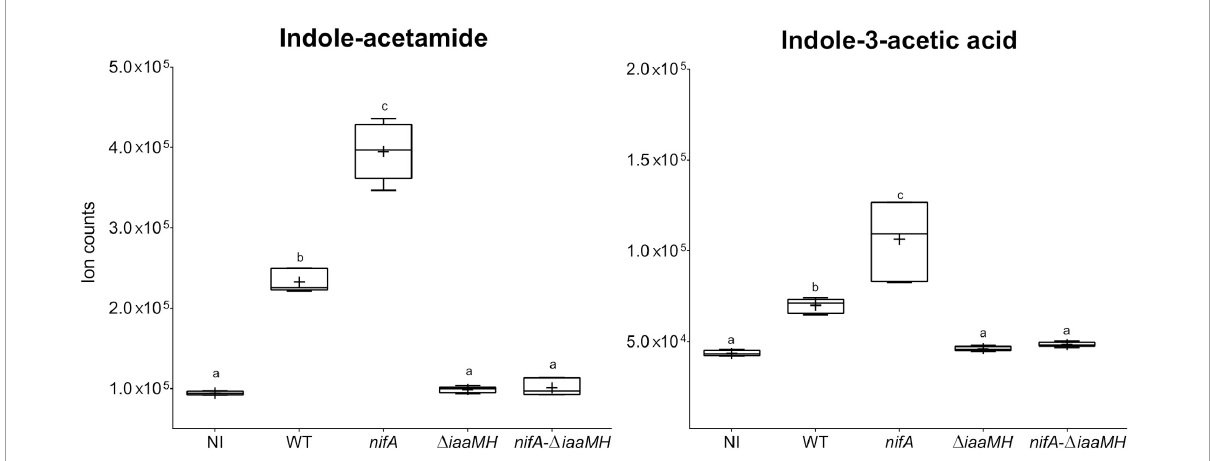
FIGURE5 Ion counts observed for indole-acetamide (IAM) and indole-3-acetic acid (IAA). The respective levels are indicated for Phaseolus vulgaris non-inoculated roots (NI) and nodules occupied by Paraburkholderia phymatum wild-type (WT), nifA mutant ( nifA ), as well as (cid:49) iaaMH and nifA- (cid:49) iaaMH double mutant strains. Plus-symbols (+) indicate the arithmetic mean while whiskers represent minimum and maximum values. Differences between samples were analyzed with one-way ANOVA with Tukey’s test ( p -value ≤ 0.05). Statistically significant differences are indicated with different letters (a–c).